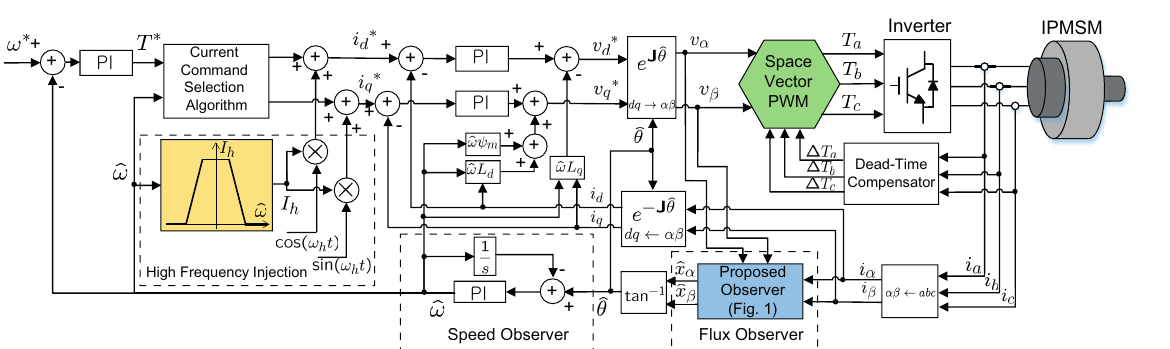
Figure 3. Sensorless control block diagram for IPMSM that employs signal injection only in the low speed